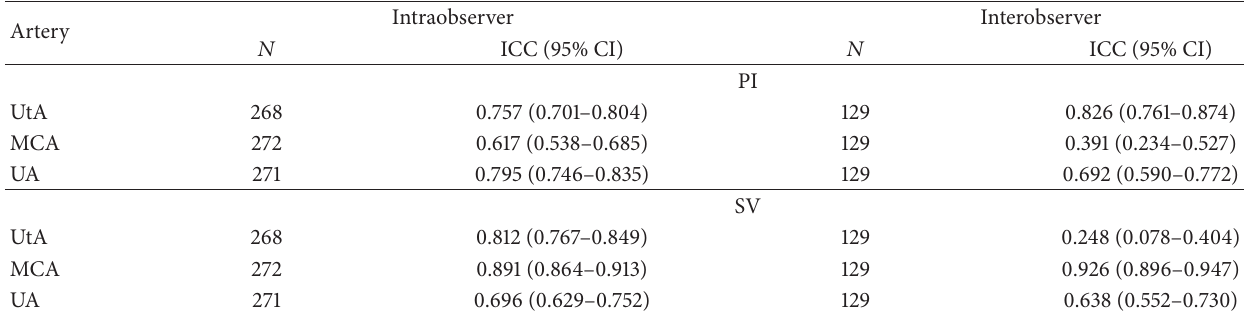
Table 4: Intra- and interobserver variability of the Doppler velocimetric measurements of PI and SV of some fetal arteries evaluated with their ICC in a cohort of low risk pregnant